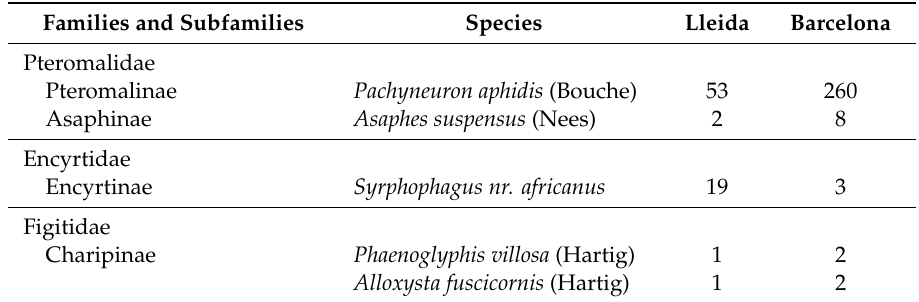
Figure 2. Seasonality of the Hyalopterus spp. parasitoid and associated hyperparasitoid species collected in Barcelona in 2017. The percentages of parasitoids and hyperparasitoids per sampling date were calculated from the total number of parasitoids and hyperparasitoids, respectively, that emerged from the mummies. X indicates that no sampling was conducted during that week. Table 3. Number of Hyalopterus spp. associated hyperparasitoid species collected during the 3-year study in both surveyed areas.